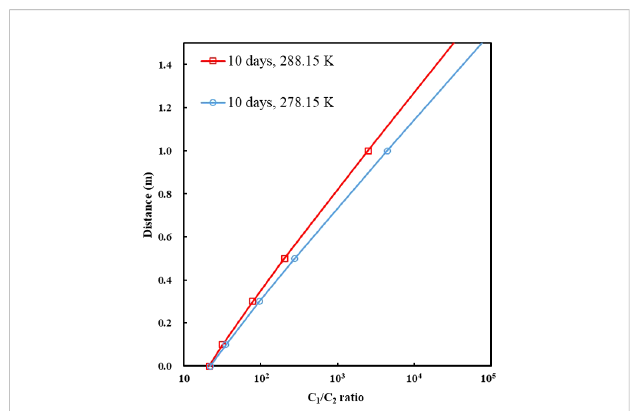
FIGURE 7 The C 1 /C 2 ratio along the depth of around 1 m above the bottom- simulating re fl ector (BSR) under the dissolution – diffusion process of a methane – ethane mixture (90% CH 4 + 10% C 2 H 6 ) at 278.15 and 288.15 K. Diffusion coef fi cients of gases are listed in Table 4. The entire duration of the numerical simulation was 10